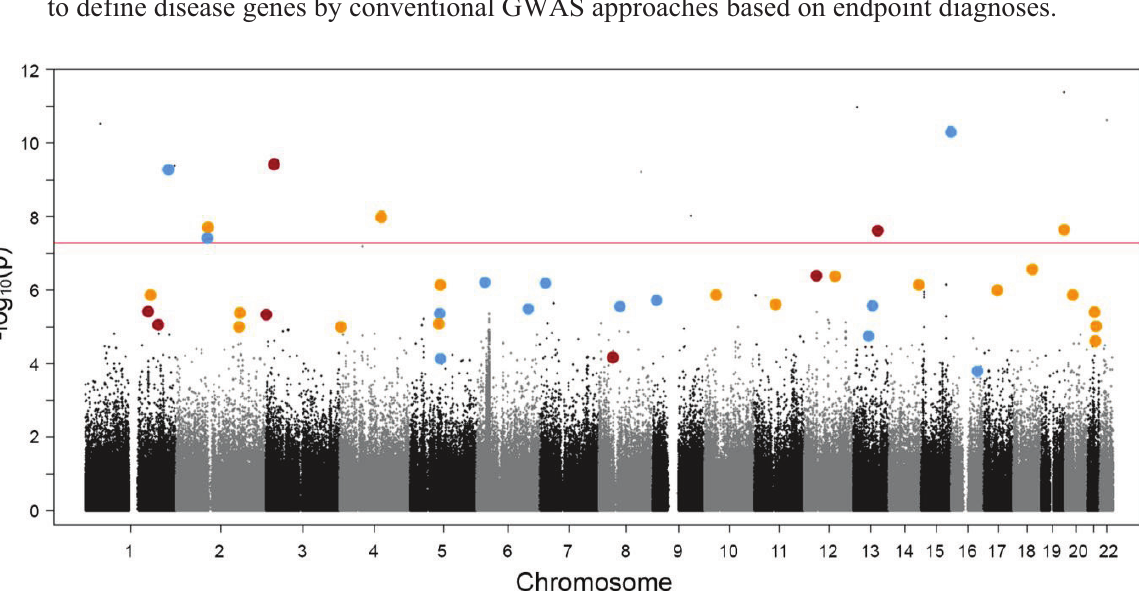
Figure 1. Schematic presentation of three hypothetical subphenotypes of schizophrenia embedded in a sample Manhattan plot. The non-overlapping red, blue or yellow dots comprise genetic constellations ( “ assemblies ” ) suggested to account for disease subforms with respective subphenotypes. Note that typical genome-wide association studies (GWAS) “ top hits ” , as defined by the highest significance levels for the clinical endpoint diagnosis ( “ schizophrenia ” ), most likely fall into different assemblies. This can explain their low odd ratios in a large and diverse patient group and the apparent lack of interactions. The depicted schema is purely hypothetical and shall illustrate the difficulties to define disease genes by conventional GWAS approaches based on endpoint